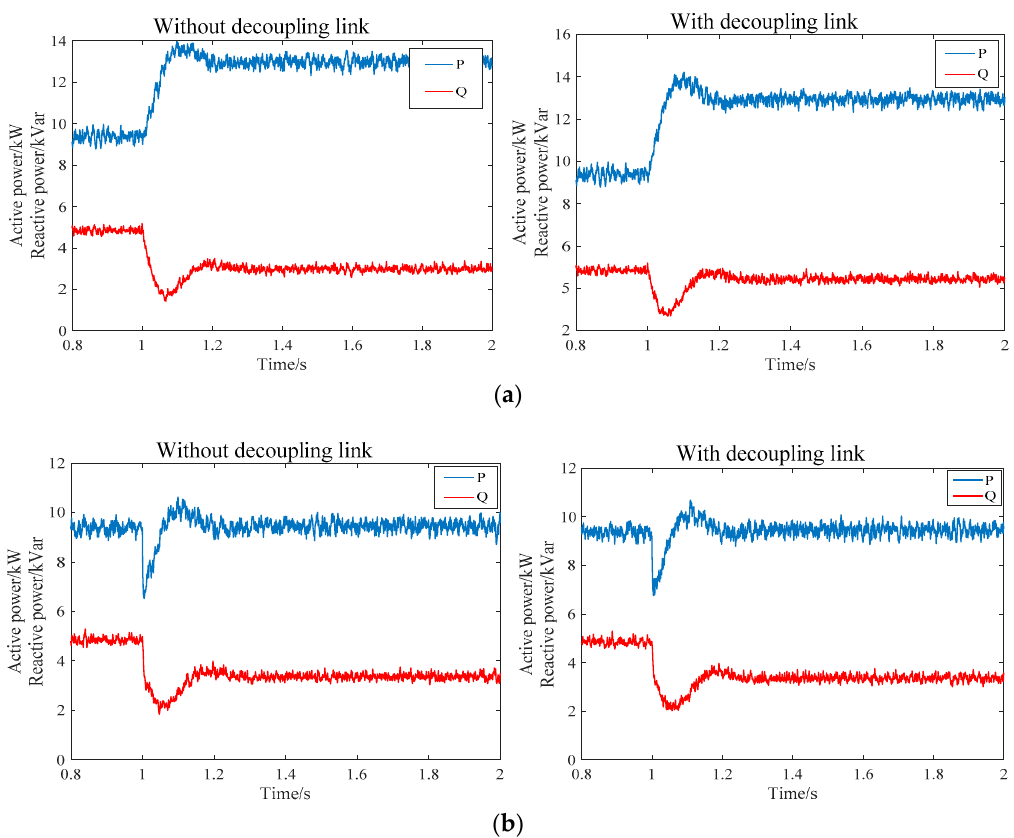
Figure 7. ( a ) The power output response to the frequency fluctuation; ( b ) The power output response to the voltage amplitude fluctuation.